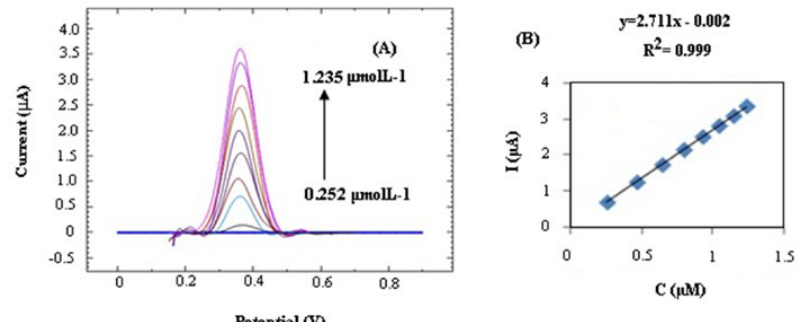
Fig. 5 . Differential pulse anodic voltammogram of insulin at GCE in the BRBS(pH=11) in the concentration range of 0.252 to 1.235 μmolL -1 , (B) concentration dependence of insulin